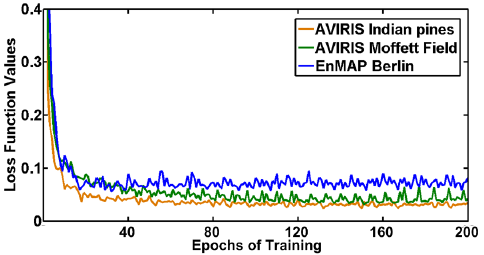
Figure 15. Evolution of loss function value over epochs of training.